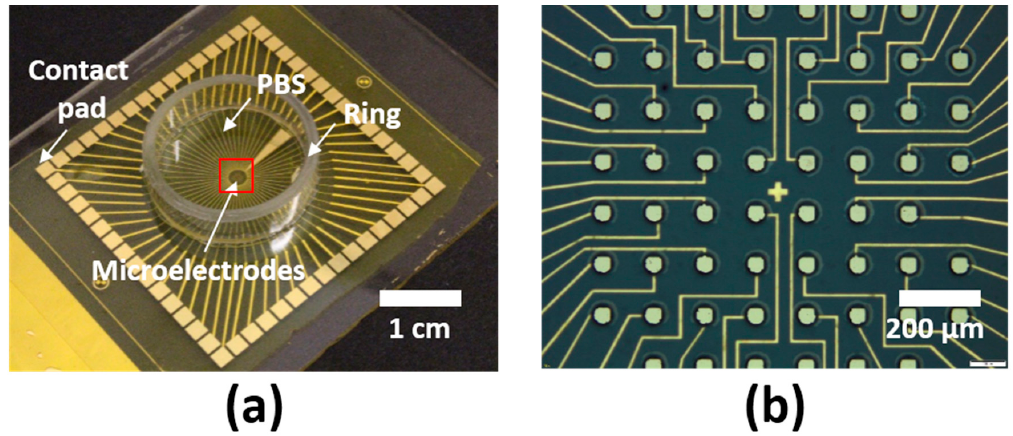
Figure 4. LCE encapsulated MEA devices: ( a ) Optical image of LCE encapsulated MEA device with polycarbonate ring attachment. Red square indicates microelectrode sites at the center of the device. ( b ) Reflection optical microscope image of the microelectrode site. 30 × 30 μ m microelectrodes are exposed by 50 μ m windows for recording of extracellular activity. Electrical traces are fully encapsulated with LCE.